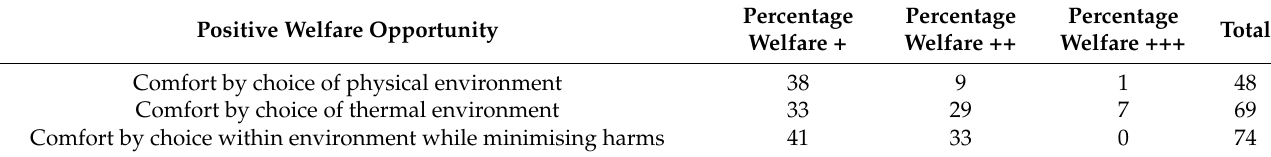
Table 1. Percentage of farmers (n = 29) achieving at least one good life resource requirement for each welfare level, expressed as a percentage of the maximum possible achievement of meeting all resource requirements for all welfare levels in that positive welfare